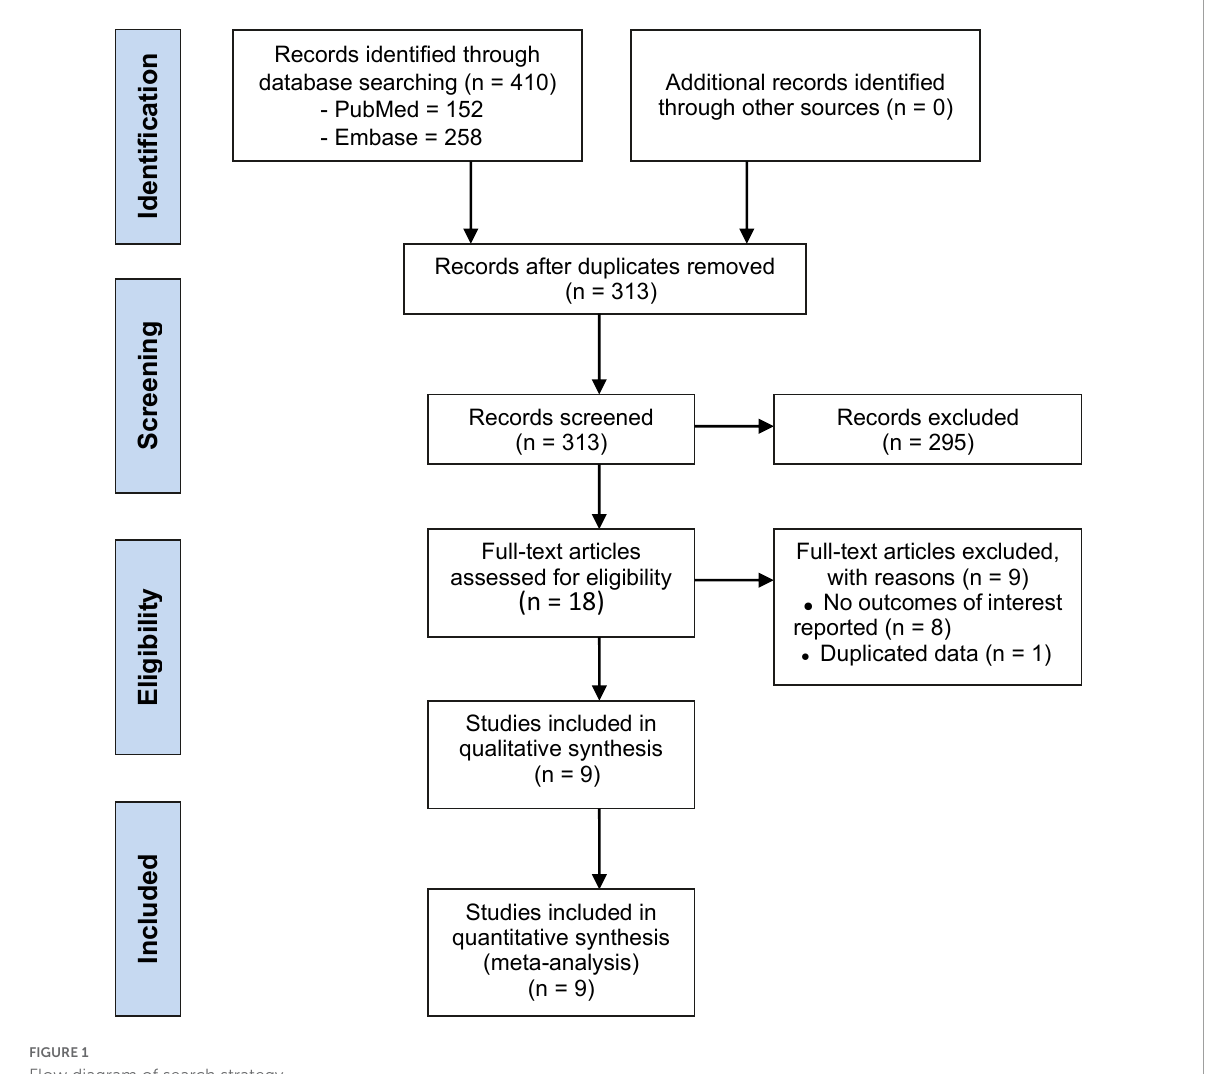
FIGURE1 Flow diagram of search